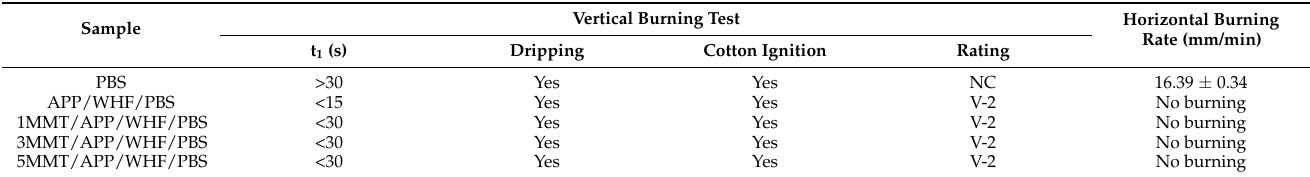
Table 9. Flammability properties of PBS and PBS